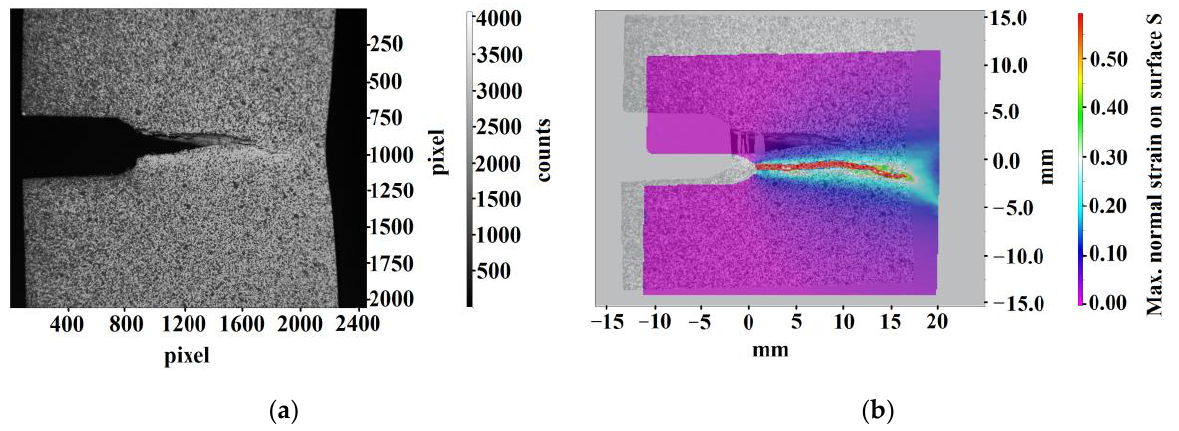
Figure 4. Photos of the surface ( a ) and normal strain fields on the surface ( b ) for one of the specimens at the moment before failure.